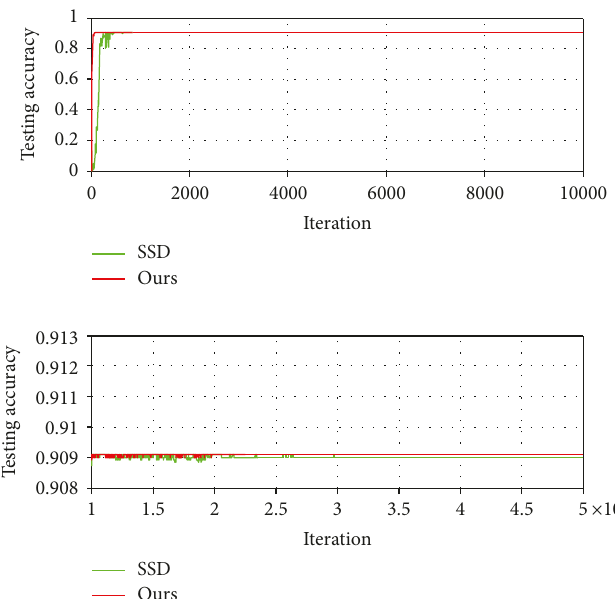
Figure 10: Comparison of testing accuracy during training procedure.